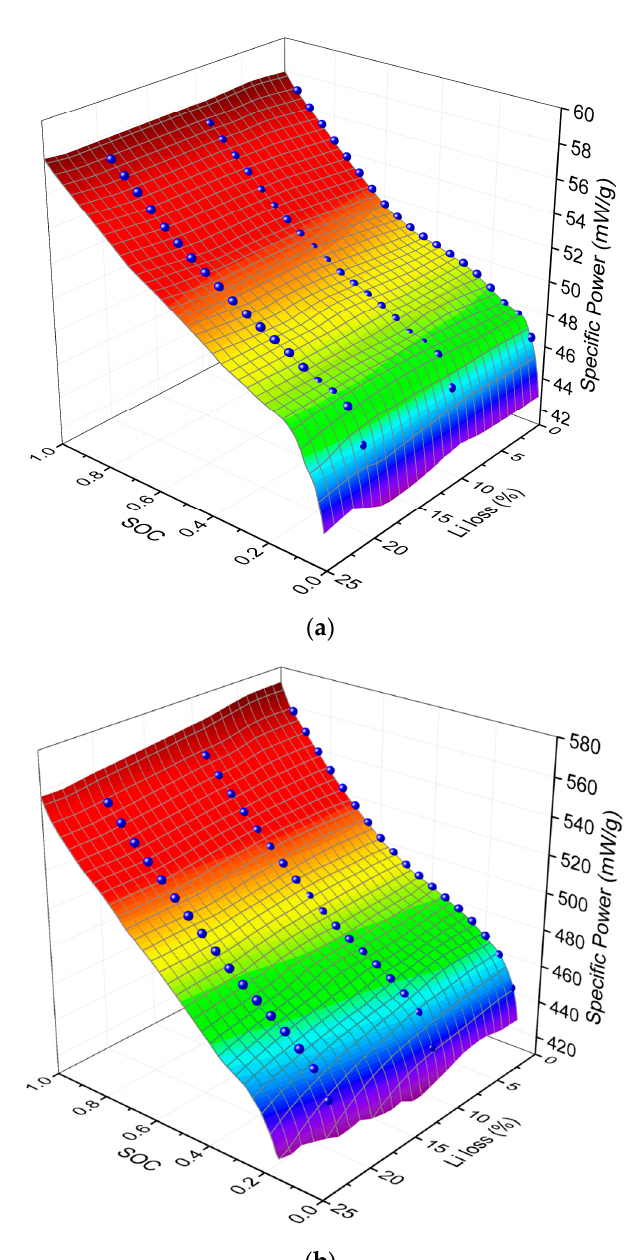
Figure 8. Three ‐ dimensional surface plots of the available discharge power as functions of SOC and of the loss of cyclable lithium for the discharge rates of ( a ) 0.05 C and ( b ) 0.5 C. The spheres are the experimental data.